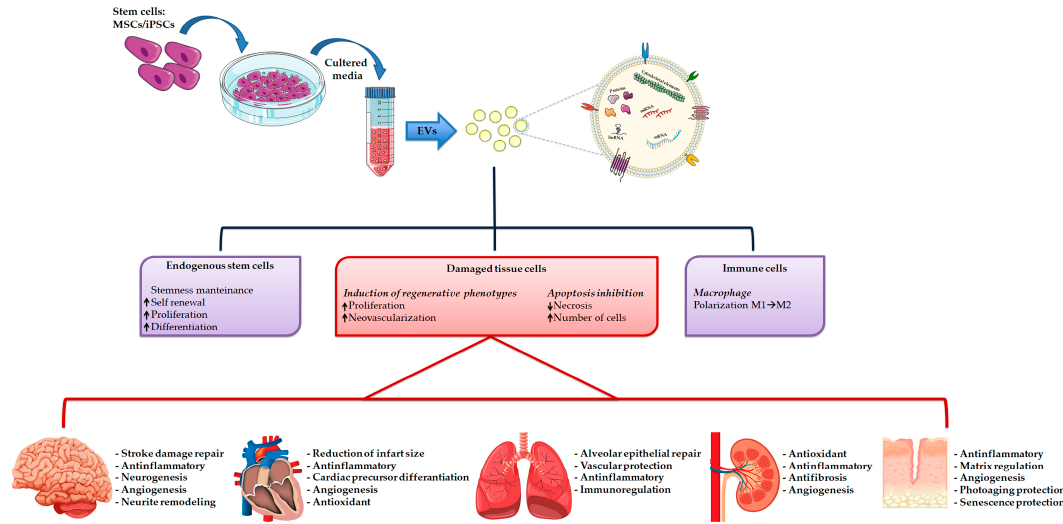
Figure 3. Extracellular vesicles isolation and their therapeutically potential in tissue repair.